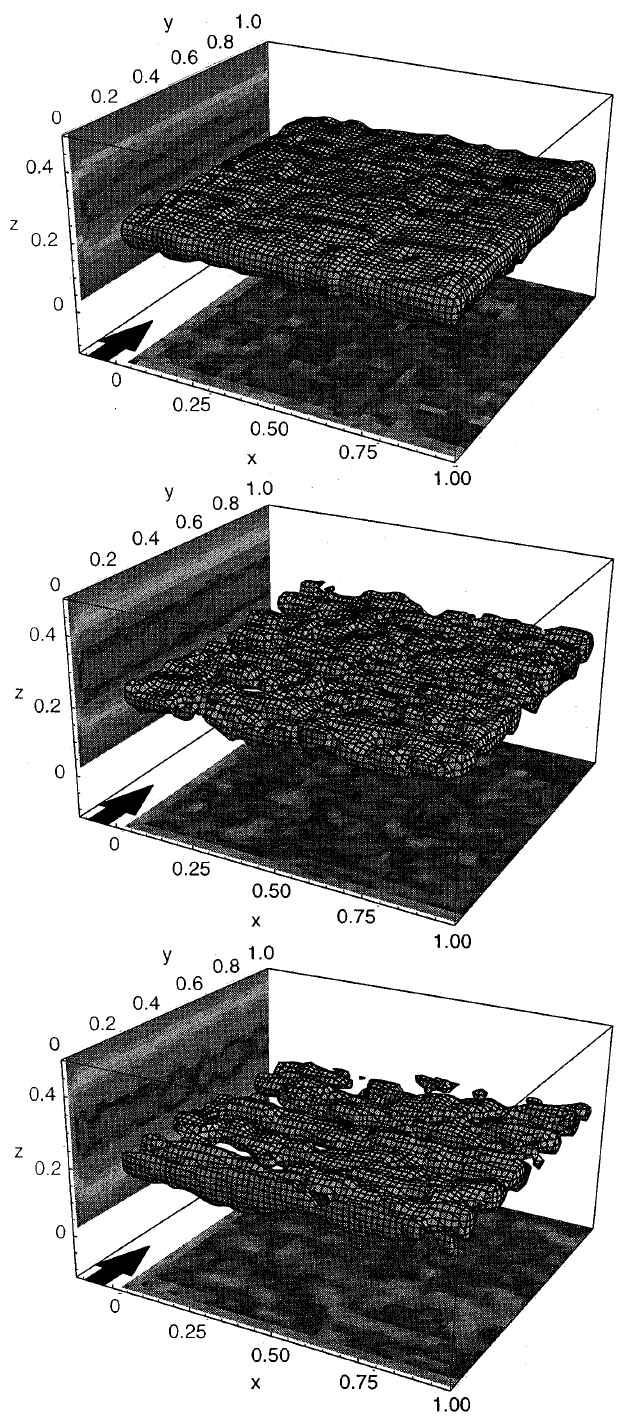
Fig. 5. Same as Fig. 4, but for a mass ratio M